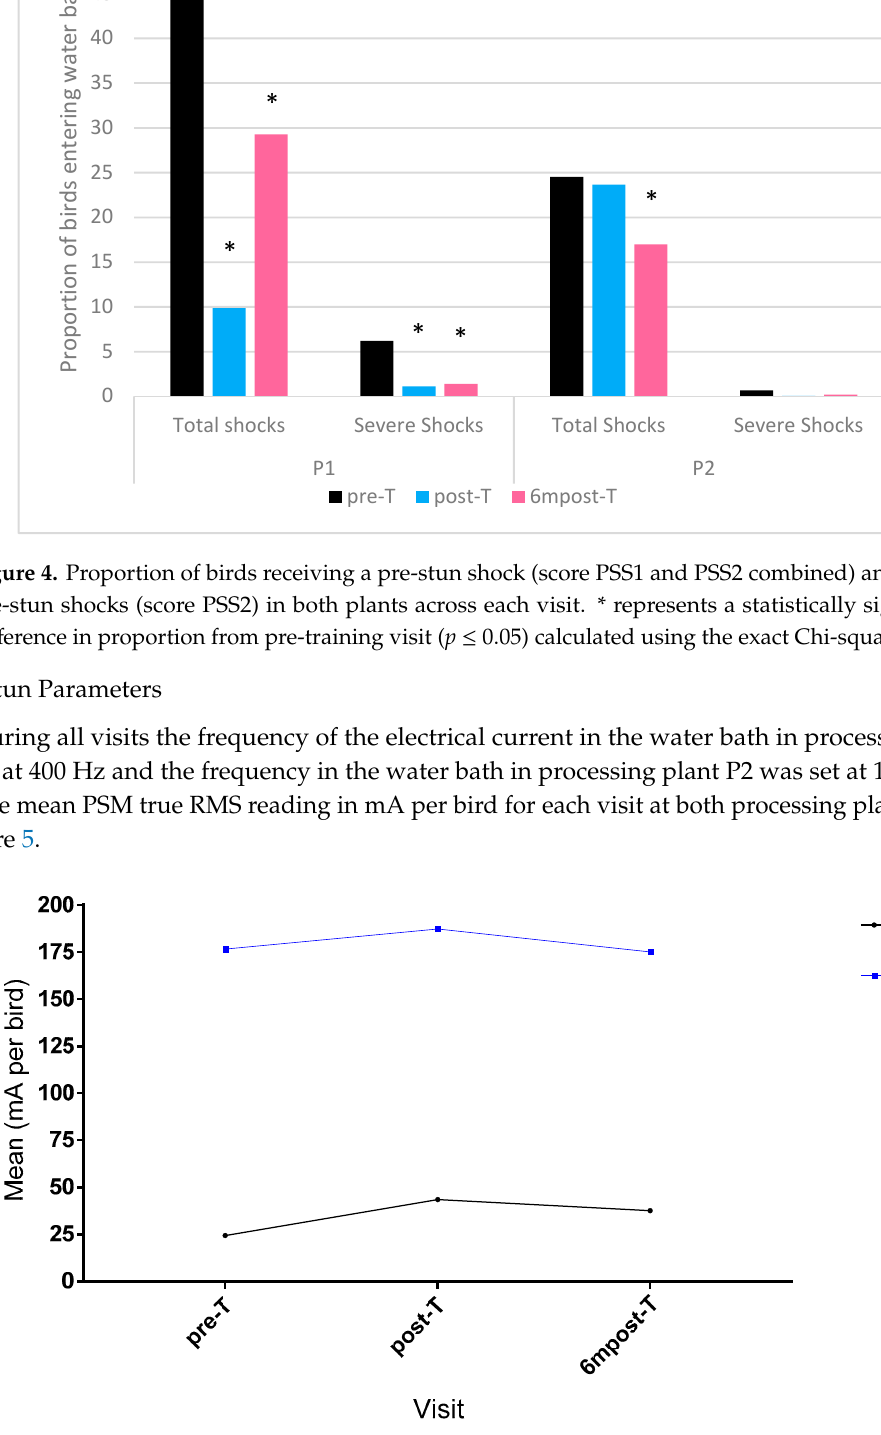
Figure 5. Mean PSM reading for each visit (n = 6 per visit) at processing plant P1 and P2. Error bars not included for clarity.